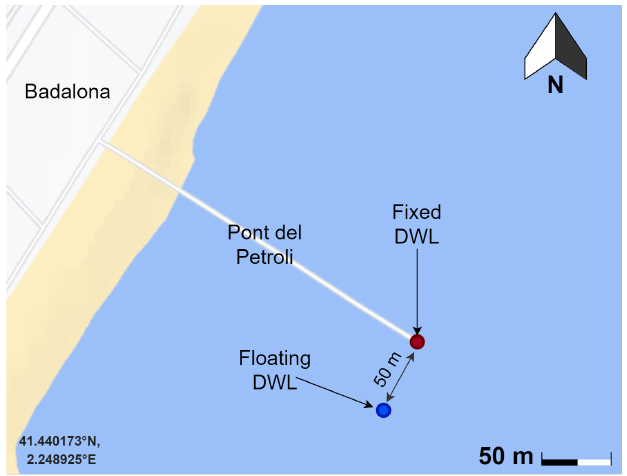
Figure 1. PdP campaign location map and experimental